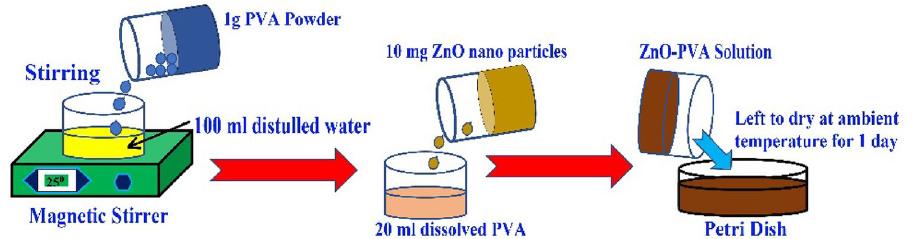
Figure 2. The fabrication process of ZnO-PVA thin-film using SM technique.